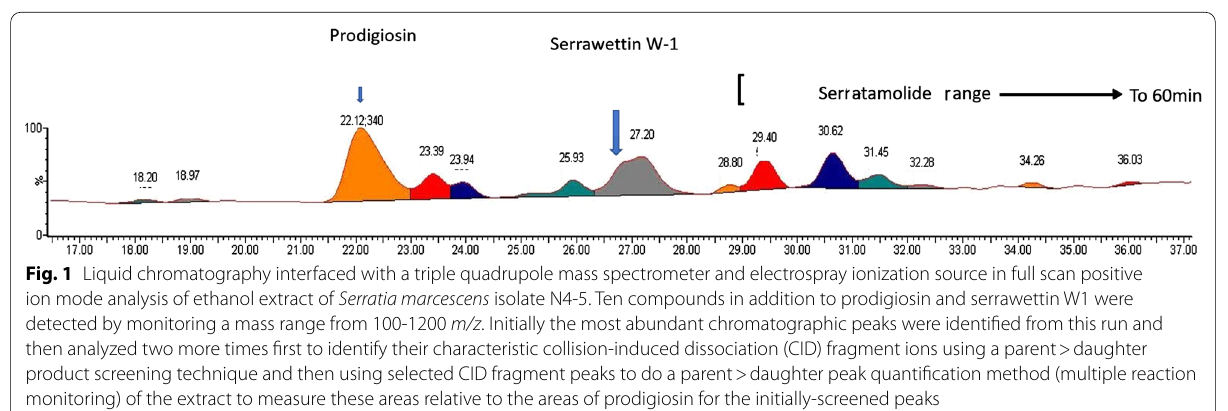
Fig. 1 Liquid chromatography interfaced with a triple quadrupole mass spectrometer and electrospray ionization source in full scan positive ion mode analysis of ethanol extract of Serratia marcescens isolate N4-5. Ten compounds in addition to prodigiosin and serrawettin W1 were detected by monitoring a mass range from 100-1200 m/z . Initially the most abundant chromatographic peaks were identified from this run and then analyzed two more times first to identify their characteristic collision-induced dissociation (CID) fragment ions using a parent > daughter product screening technique and then using selected CID fragment peaks to do a parent > daughter peak quantification method (multiple reaction monitoring) of the extract to measure these areas relative to the areas of prodigiosin for the initially-screened